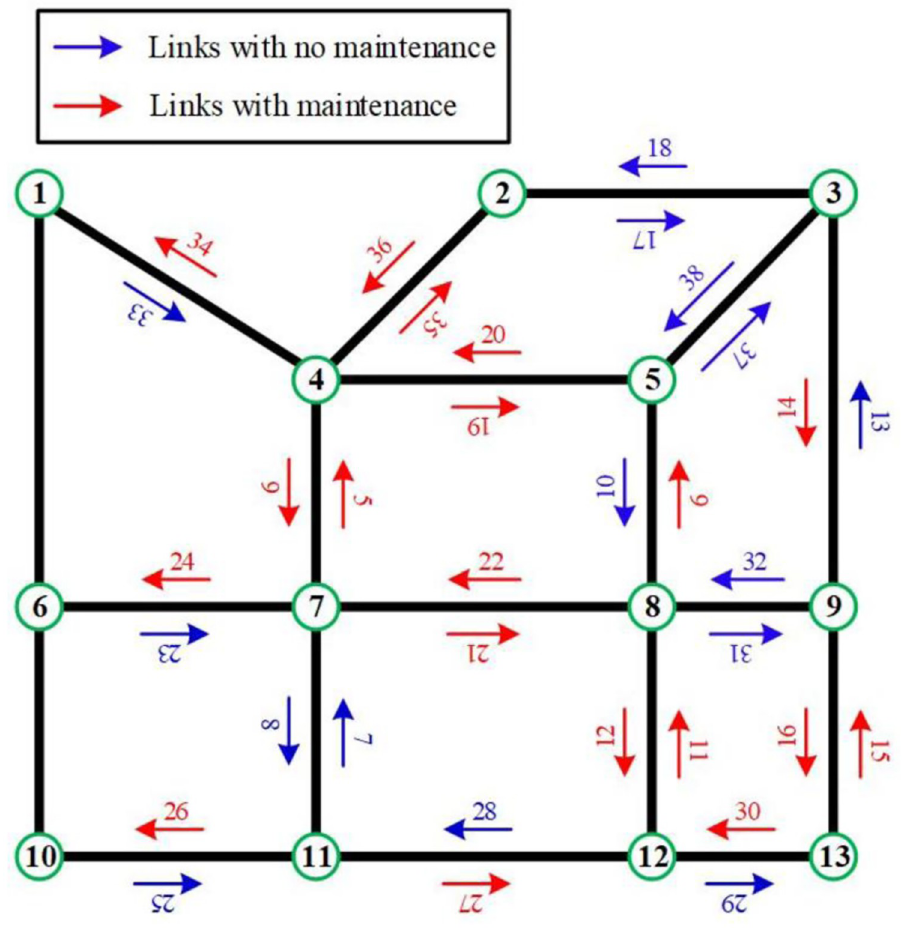
Fig 4. A highway network.